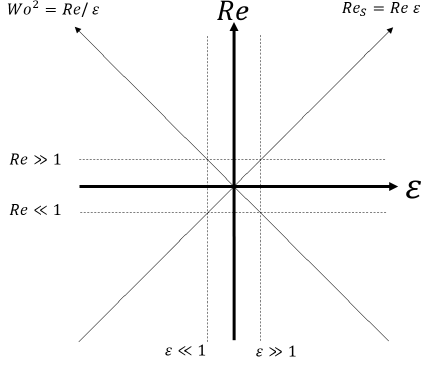
Figure 1. (cid:101) - Re plane by Heidinger et al. [10] in which all flow states of a single particle in an oscillating flow can be defined. Note that the origin has the coordinates (cid:101) = 1, Re =